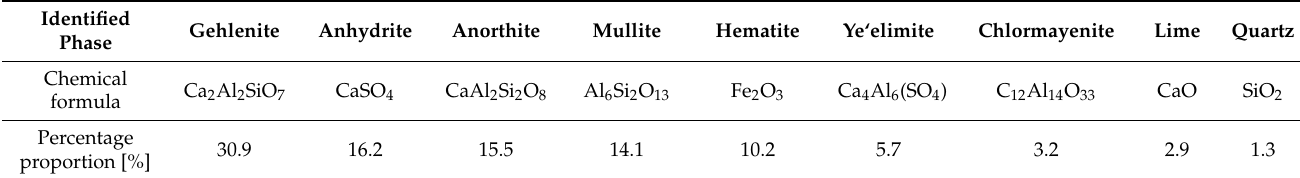
Table 3. The phase composition of fly ash from